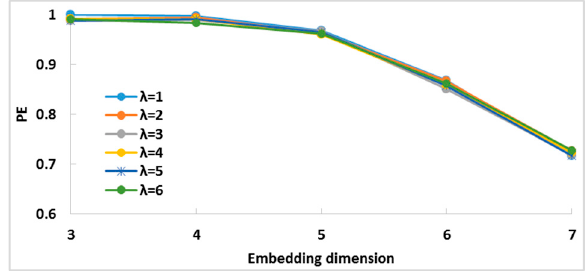
Figure 3. PE of Gauss white noise with different time delays.